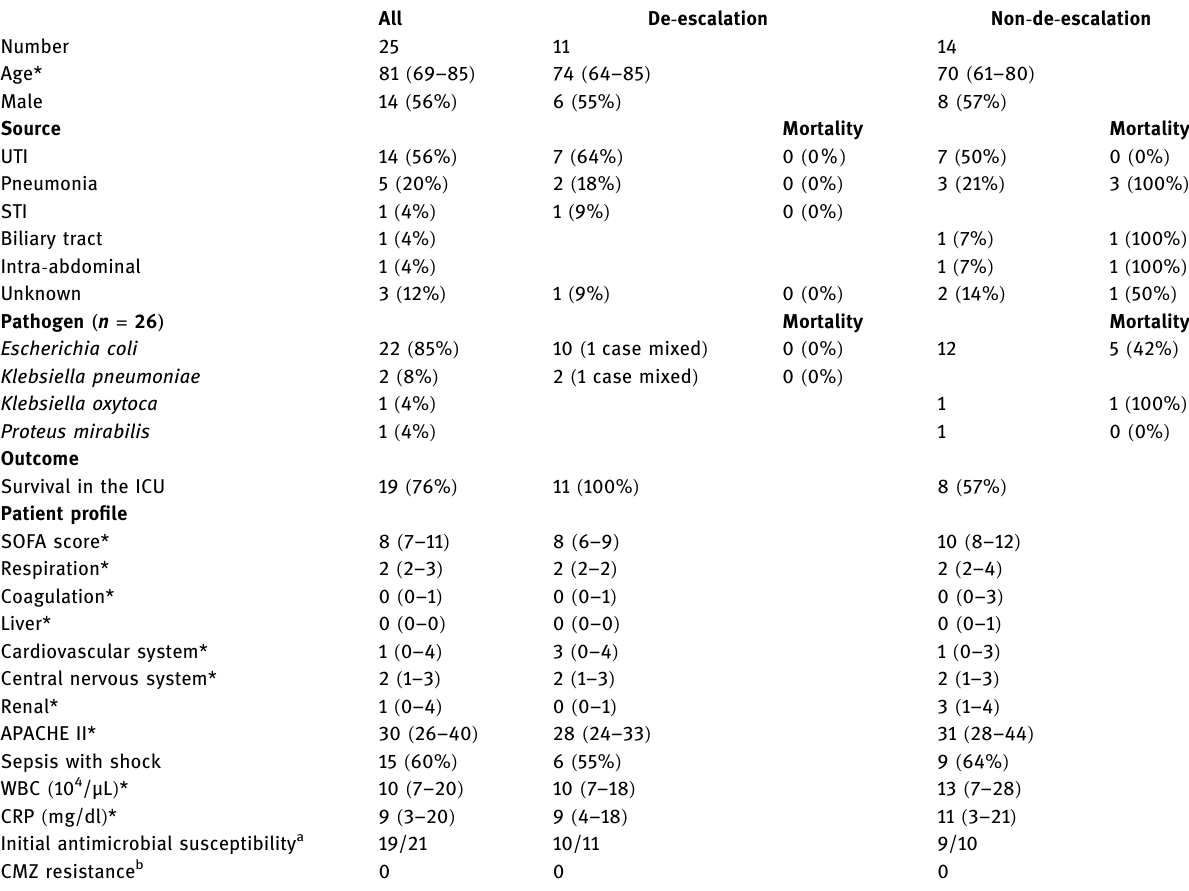
Table 2: Baseline characteristics of patients in the de - escalation and non - de - escalation groups and patient mortality